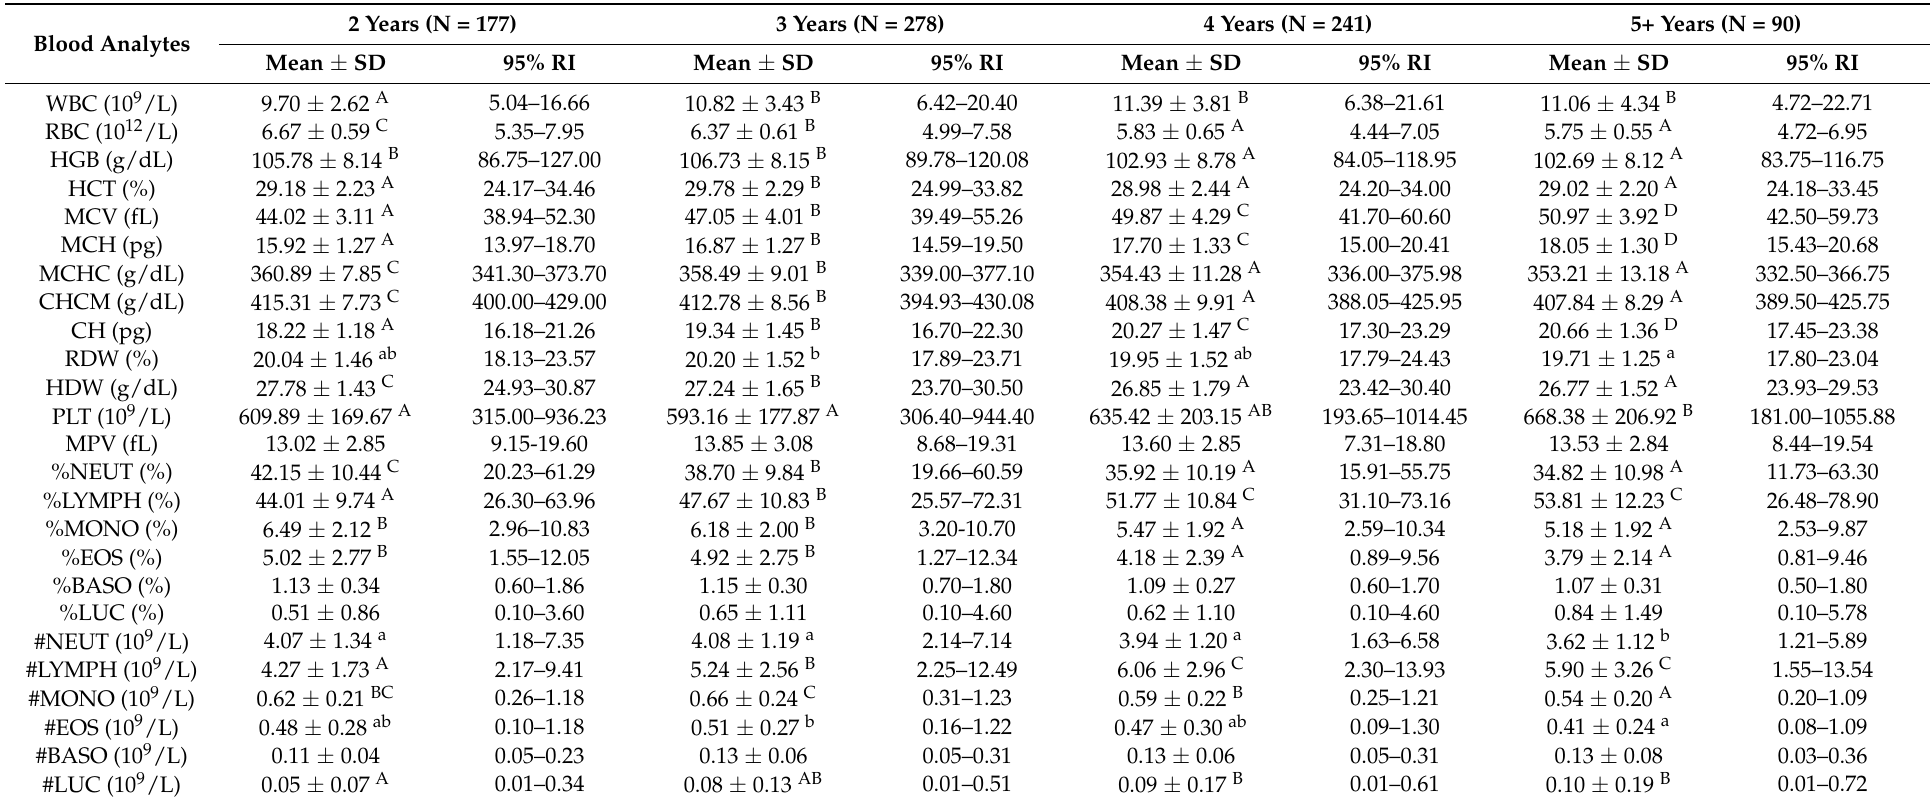
Table 2. Hematology values and RIs for Holstein cows at different